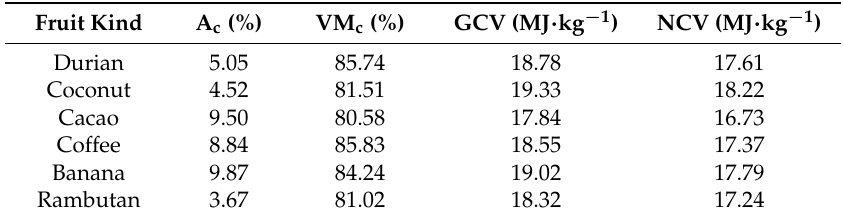
Table 5. Basic chemical parameters of investigated fruit waste biomass in dry basis (d.b.).